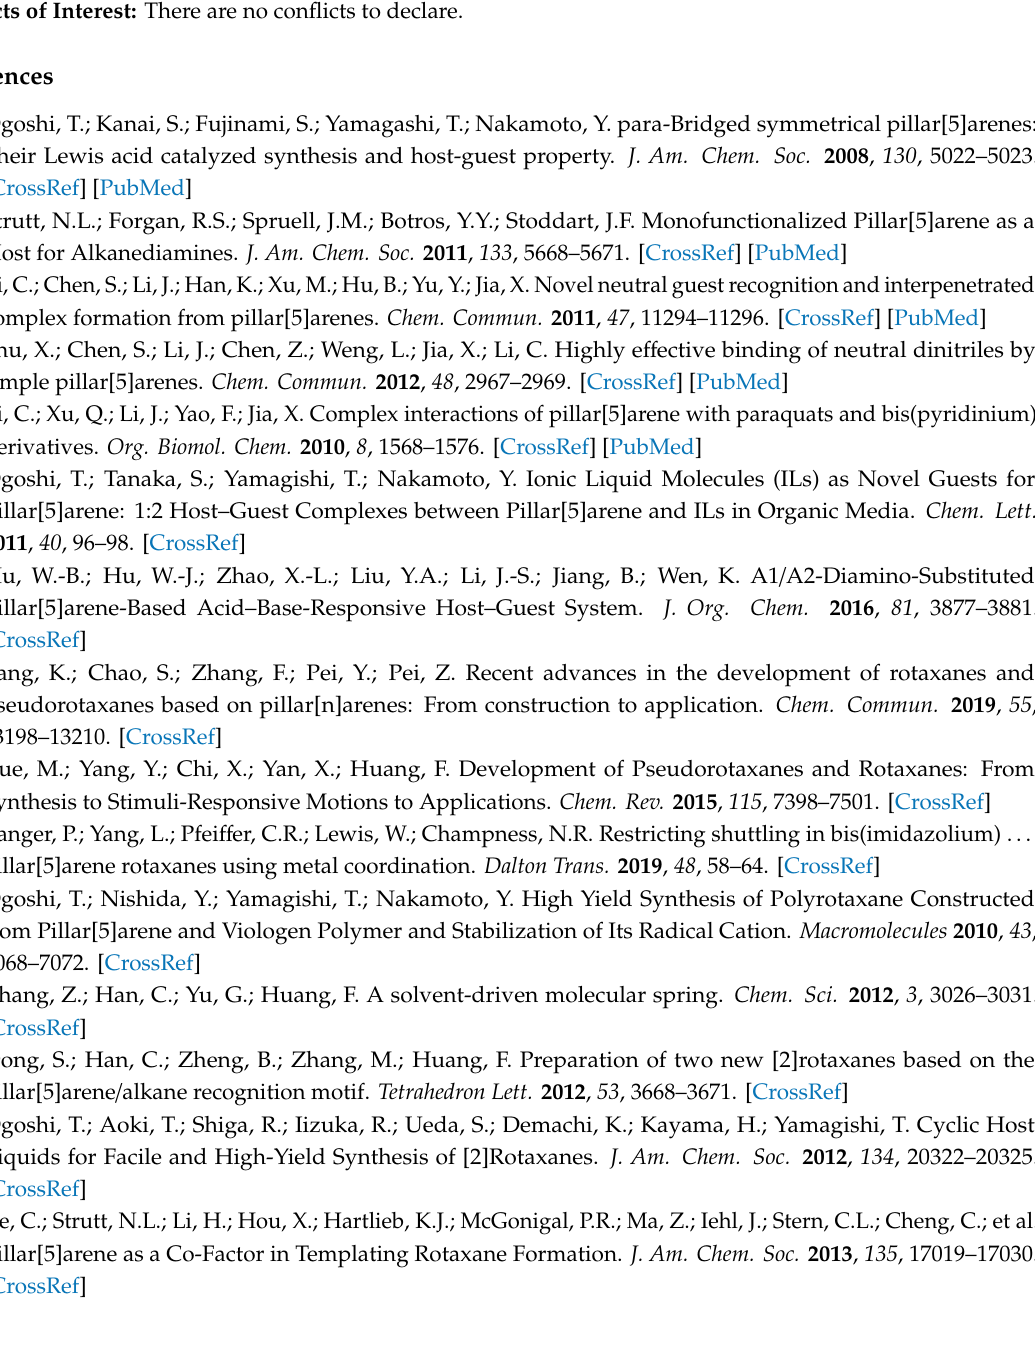
Supplementary Materials: The following are available online, Experimental details, Figure S1: Scan rate data for all compounds; Figure S2: Square wave voltammograms for all compounds; Figures S3 and S4: UV-vis absorbance spectra for P5A; Figure S5: UV-vis absorbance spectra for [P5A-Rot](PF 6 ); Figures S6 and S7: UV-vis absorbance spectra for P4A1Q; Figure S8: UV-vis absorbance spectra for P3A2Q; Figure S9: EPR spectrum of [P5A-Rot] 3 + ; Figures S10 and S11: EPR spectra of [P3A2Q] 2- ; Figure S12: EPR spectrum of [P4A1Q] +